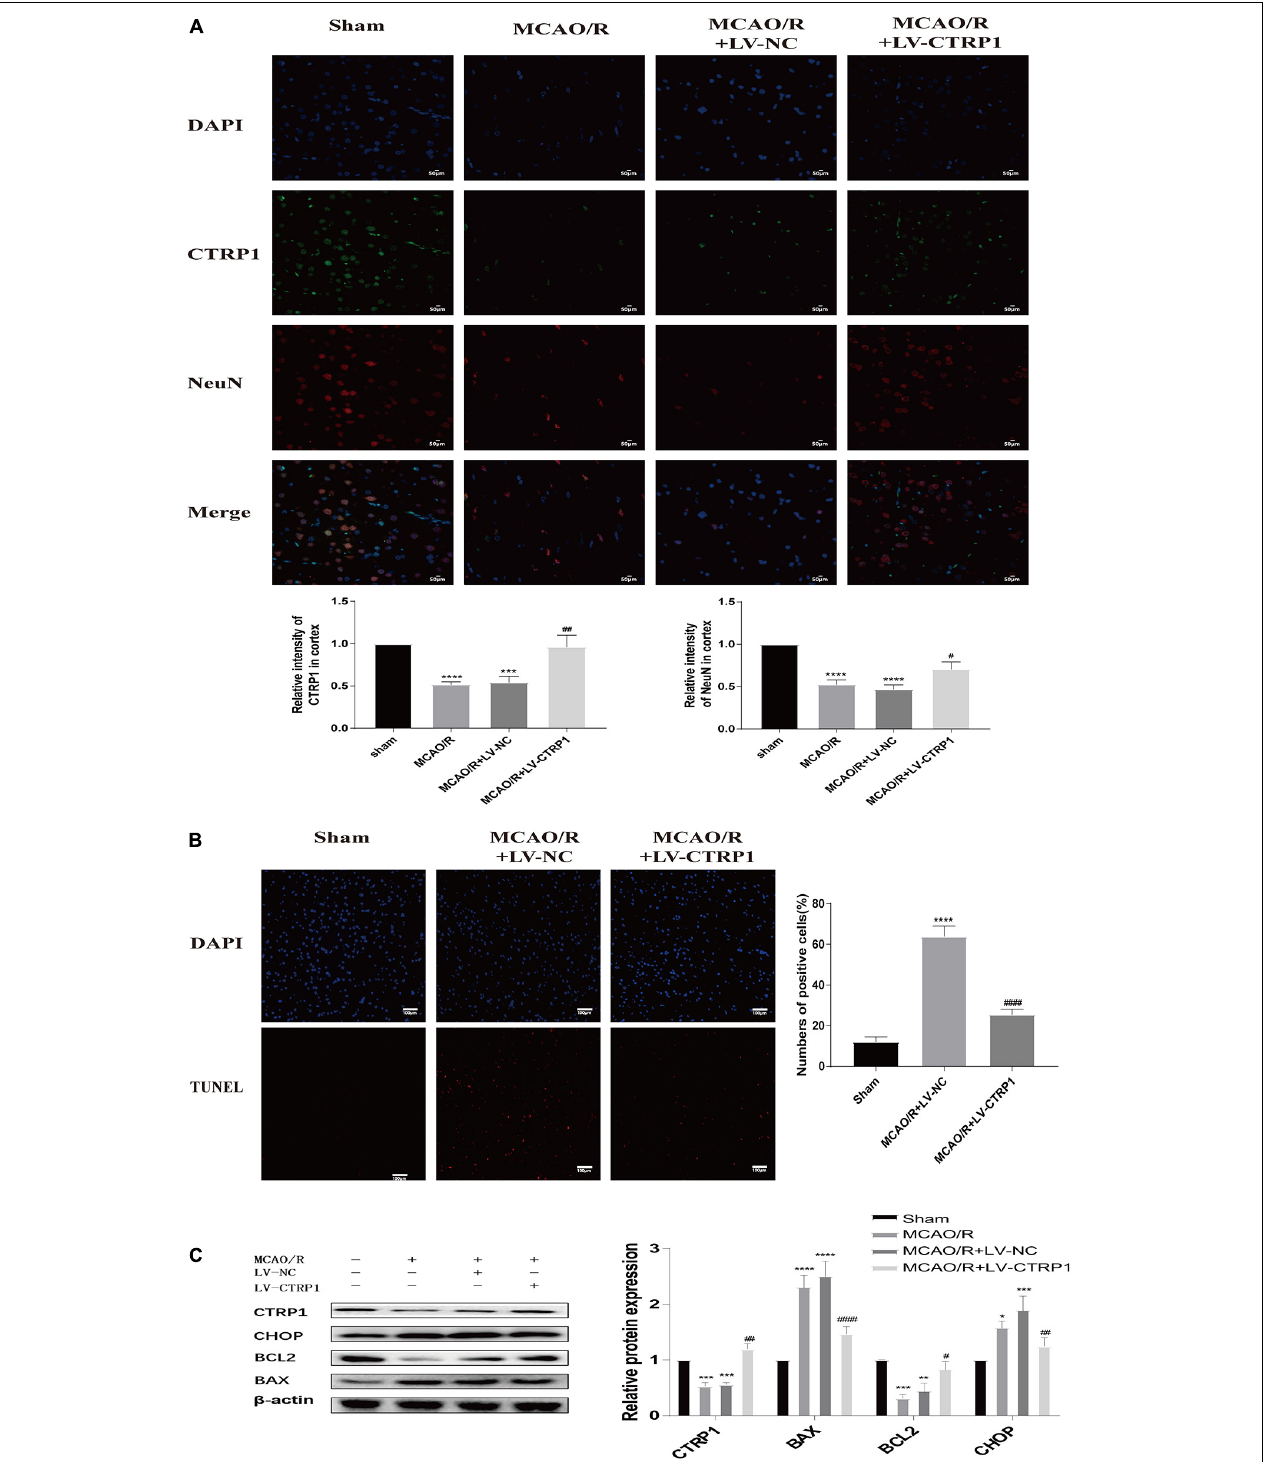
FIGURE 4 | CTRP1 protected against cerebral ischemia reperfusion injury via alleviating neuron injury and apoptosis. (A) Neuron injury was analyzed by double labeling immunofluorescence staining. n = 3 per group. The representative images were acquired under × 400 magnification, scale bars = 50 µ m. (B) Apoptosis in the cortex was analyzed by TUNEL, n = 3 per group. The representative images were acquired under × 200 magnification, scale bars = 100 µ m. (C) Western blot analyzed the expression of CTRP1, BAX, Bcl-2, and CHOP in cortex. n = 4 per group. **** p < 0.0001, *** p < 0.01, ** p < 0.01, * p < 0.05 vs. sham group; #### p < 0.0001, ## p < 0.01, # p < 0.05 vs. MCAO/R + LV-NC group.